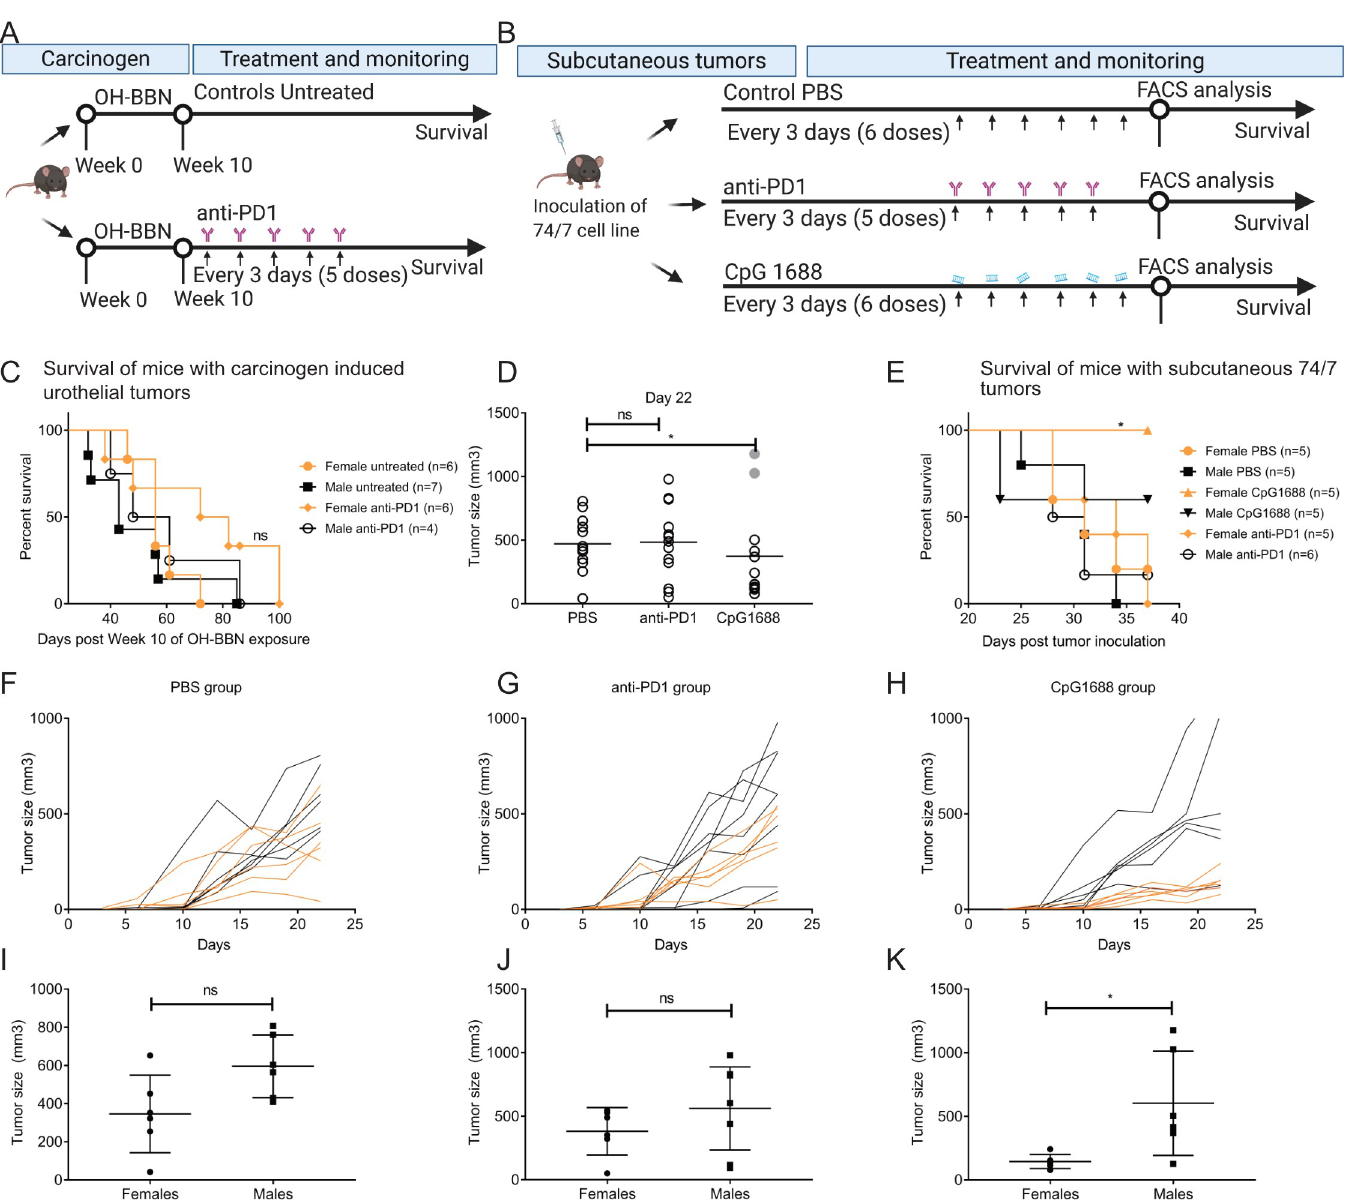
Fig 6. Experimental design and immunotherapy outcomes of OH-BBN induced or engrafted Hgf-Cdk4 R24C tumors. (A) In OH-BBN induced mice, the anti-PD1 therapy was administered intraperitoneally twice a week for 3 weeks (6 doses 100 μ g/mouse) with onset at one week after the disruption of carcinogen exposure, while untreated animals did not receive mock therapy. (B) 74/7 tumors were inoculated and treated with PBS, anti-PD1 (5 doses) or CpG 1668 (6 doses) administered peritumorally every third day starting at day 10 post inoculation. (C) Survival curves were not statistically different (p = 0.2406) in carcinogen induced animals upon anti- PD1 therapy. (D) The size of subcutaneous 74/7 tumors at day 22 was significantly reduced after CpG 1688 treatment (p = 0.0138), while (E) female mice treated with CpG 1688 survived significantly longer (p = 0.05) than the other groups. (F-H) Tumor size comparison between female (orange lines) and male (black lines) animals over time and (I-K) at day 22 showed that females receiving CpG 1688 therapy displayed significantly reduced tumor size by day 22 (p = 0.026). revealed several overlapping up-regulated proteins at early time points and the MIBC endpoint between sexes (S2E Fig), while hierarchical clustering based on significantly altered proteins reveals that male and female samples are partially clustered together by sex although the num- ber of samples might be too low to allow this assumption (S2A–S2D Fig).